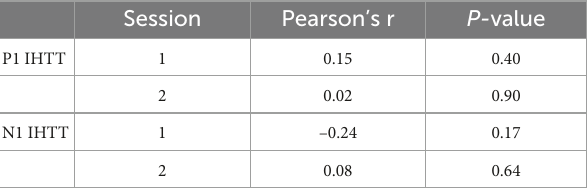
TABLE 7 Correlations between indirect minus direct differences responses times and P1 and N1 interhemispheric transfer time